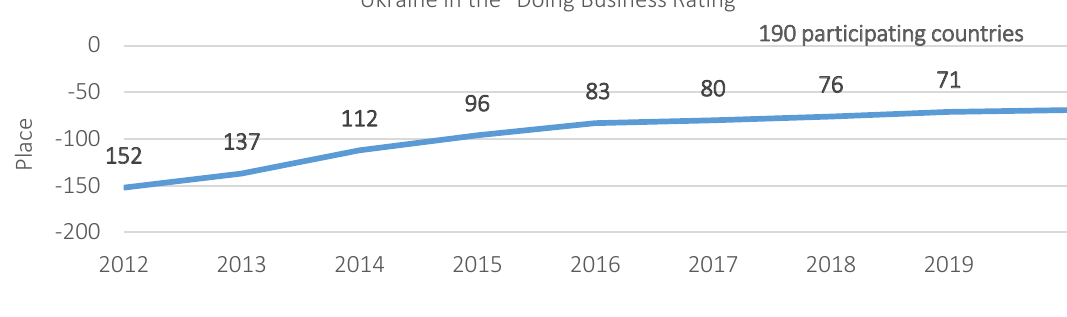
Figure 5. Ukraine in the Doing Business Rating in 2012–2019